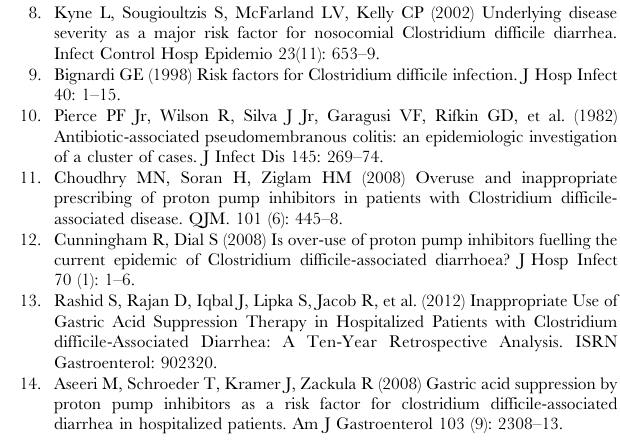
Patients without a C.difficile test - Controls type 2